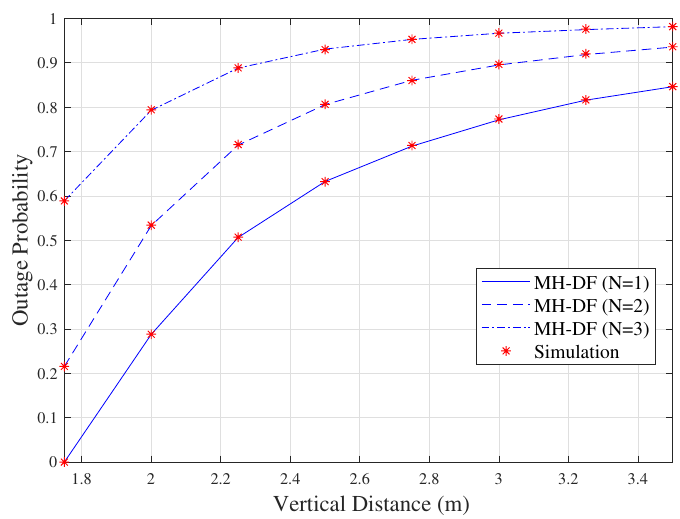
Figure 5. Outage probability of DF multi-hop scenarios (for N = 1, 2 and 3).